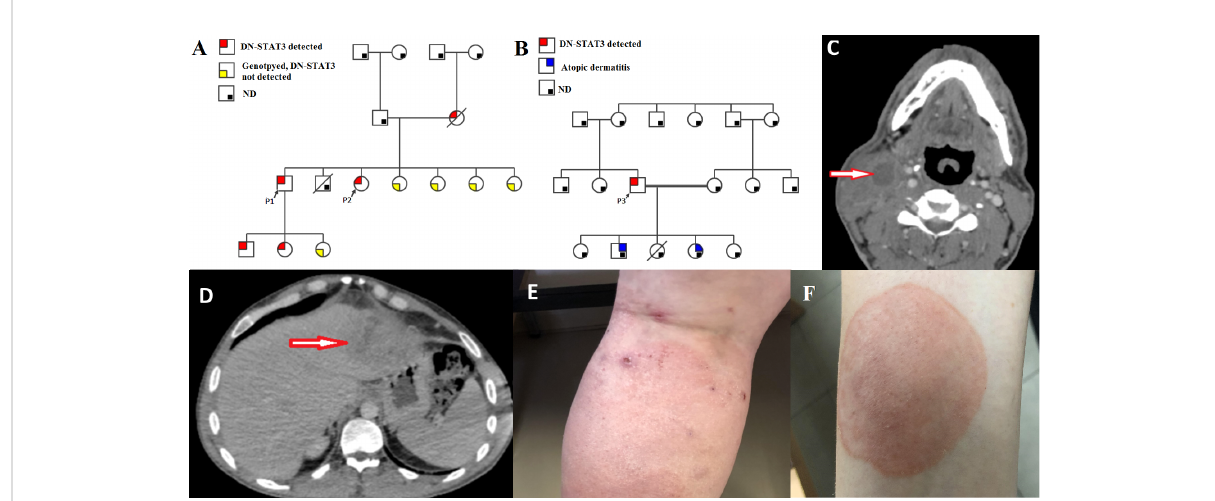
FIGURE 1 Clinical characteristics of the patients. (A, B) Family pedigrees of P1-P2 and P3, respectively, demonstrative of an autosomal dominant inheritance. In red, patients that were genotyped for STAT3 and were found to harbor DN- STAT3 variants; In yellow – Subjects that were genotyped and were not found to harbor the DN- STAT3 variant; In grey – Subjects that were not genotyped and therefore presence of DN- STAT3 variant cannot be determined or ruled out. ND- not determined. Note patients within 3 generations in the family of P1-P2. DN-STAT3- Dominant negative STAT3 variant. (C) Computed tomography (CT) scan of cervical spine of P3, axial view, demonstrating a collection with septations in the sternocleidomastoid muscle measuring 20*41*14 mm with reactive muscle and soft tissue edema. (D) Abdominal CT scan of P3, coronal view, demonstrating multiple hypodensities in the left liver lobe (segment 2 and 3) and a hepatic abscess measures 8.2*7.9 cm. (E) Atopic dermatitis, as seen in P2. (F) Tinea corporis, as seen in P2.